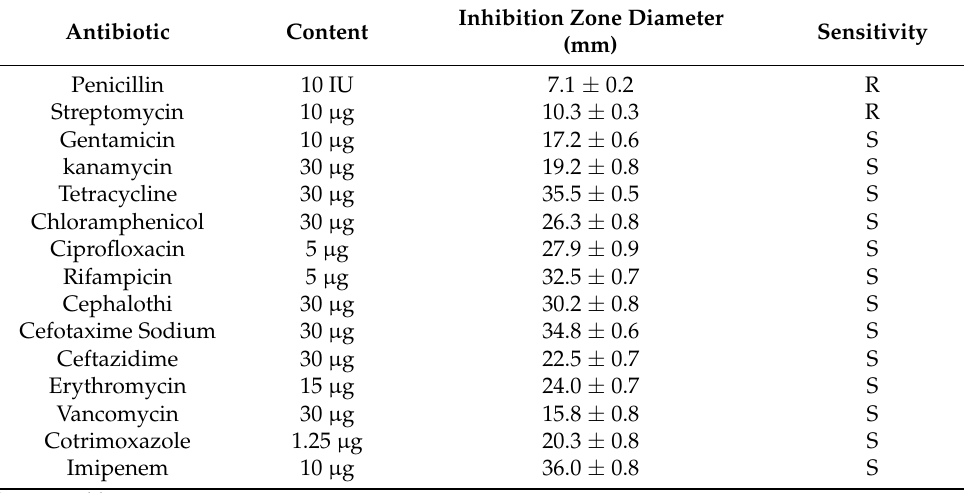
Table 4. Antibiotic susceptibility of L. salivarius